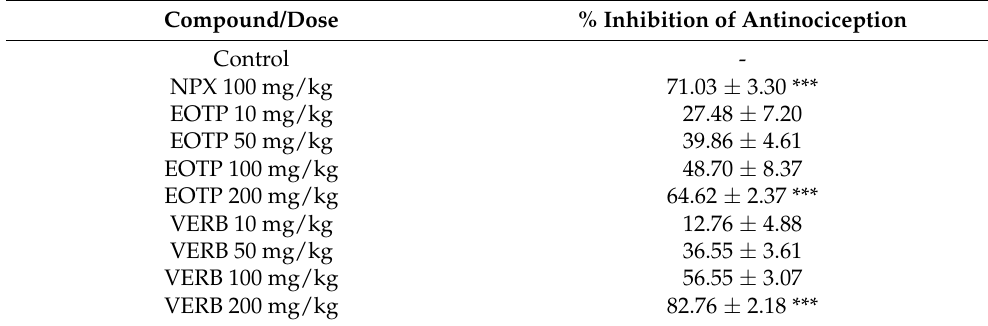
Table 3. The antinociceptive activity of EOTP and VERB in the acetic acid-induced writhing model.